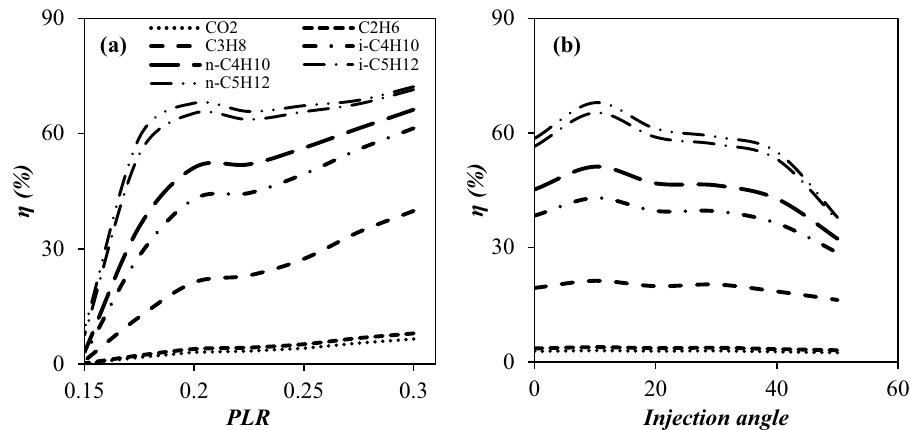
Figure 16. The influence of PLR at injection angle of 10° ( a ) and injection angle at PLR = 0.2 ( b ) on the component collection